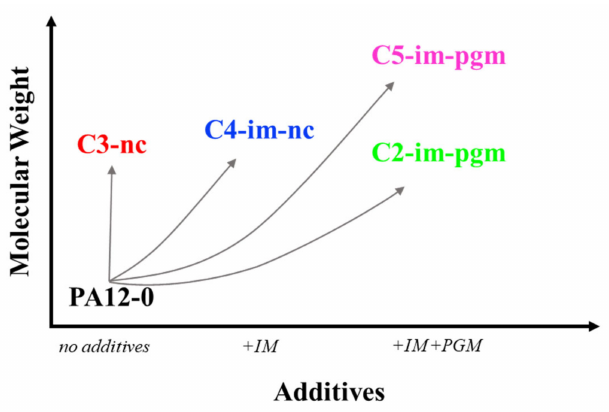
Figure 2. Systematically developed series of unplasticized PA12